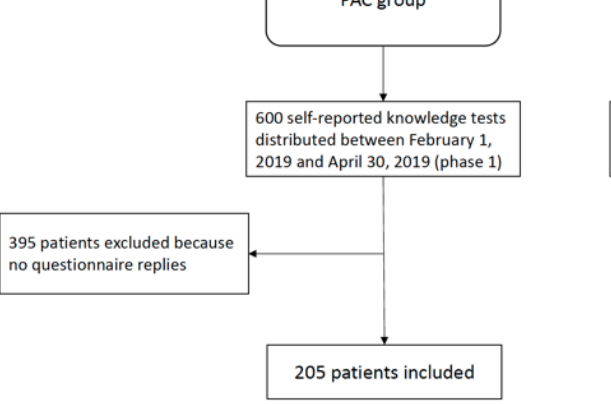
Demographic characteristics are presented in Table 1. The number of previous anesthetics received and the number of years of postgraduate education were comparable between